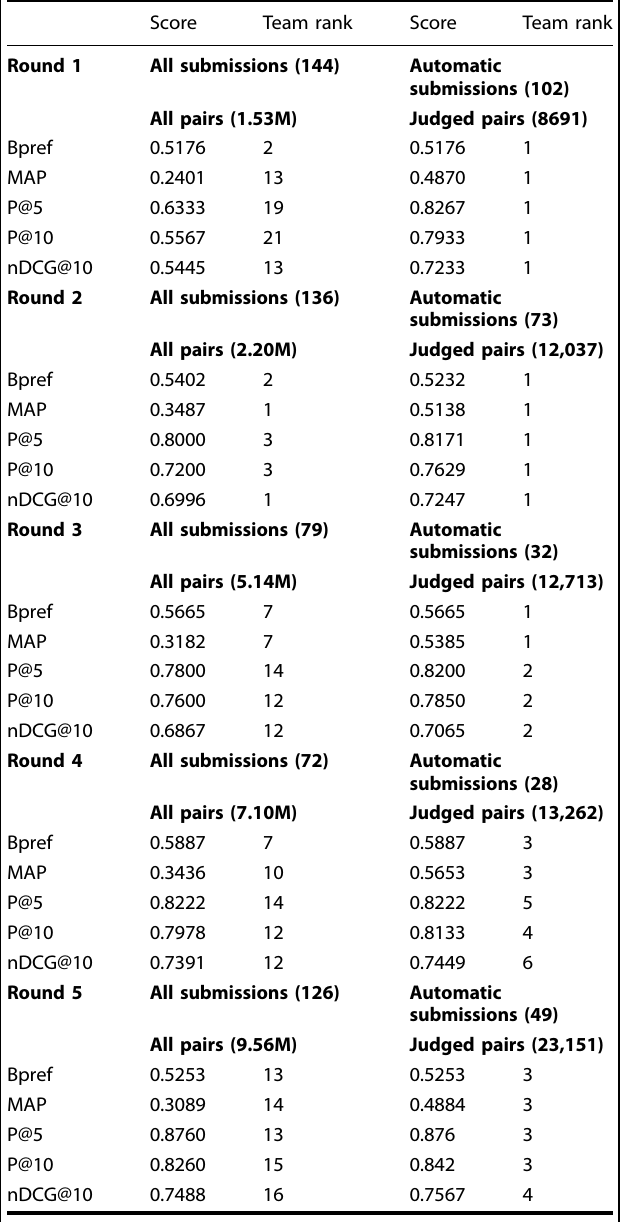
Table 2. TREC-COVID